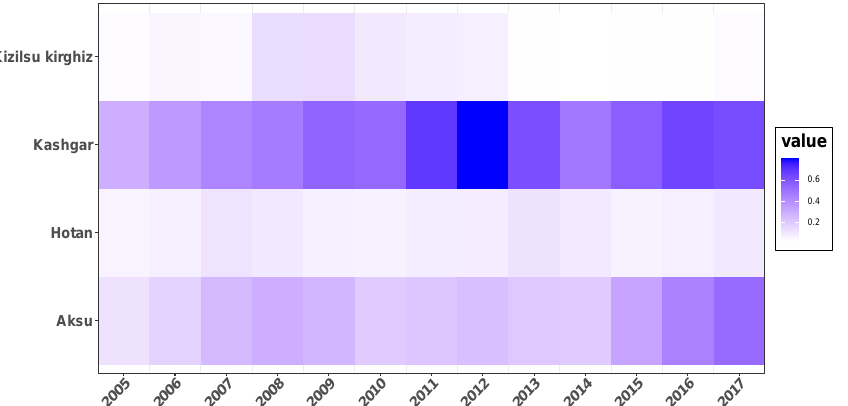
Figure 5. Incidence of HB among men over 35 years of age in four regions of Xinjiang from 2005 to 2017